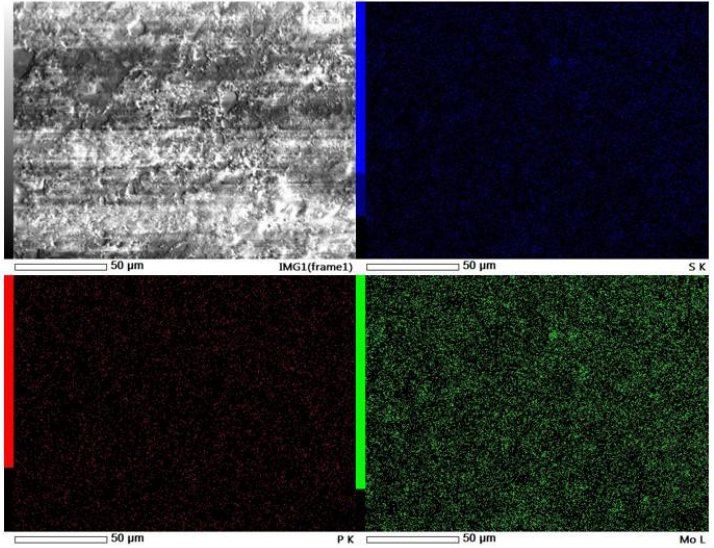
Figure 3. SEM micrograph and distribution of sulfur, phosphorus, and molybdenum on the surface of the PMo1 molybdenum catalyst.